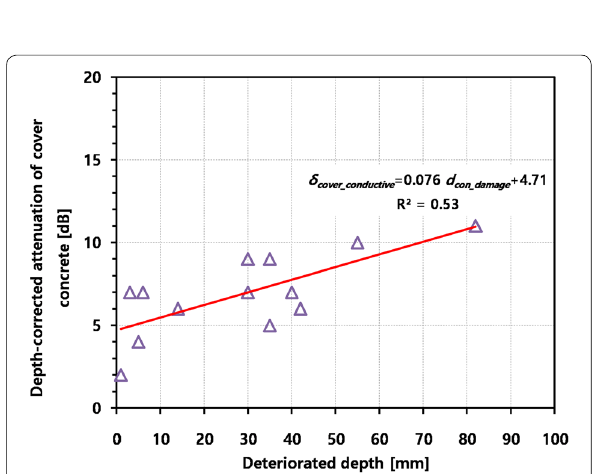
Fig. 14 Relationship between the depth‑corrected attenuation measured by air‑coupled GPR system on the pilot bridge and deteriorated depth measured from core samples.